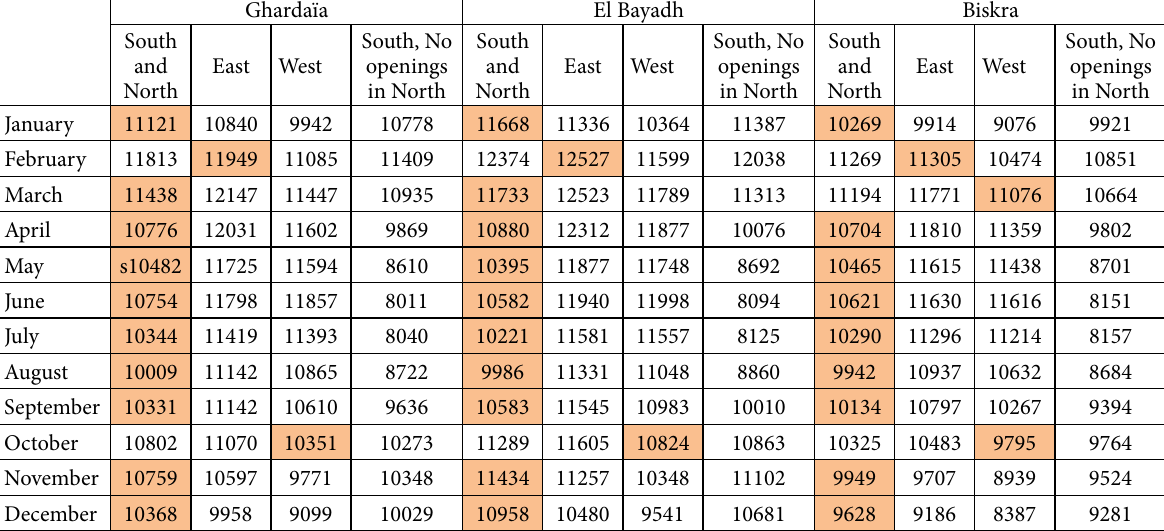
Table 6. Average daily irradiation (Wh m –2 ) for Ghardaïa, El Bayadh and Biskra region respectively Ghardaïa El Bayadh